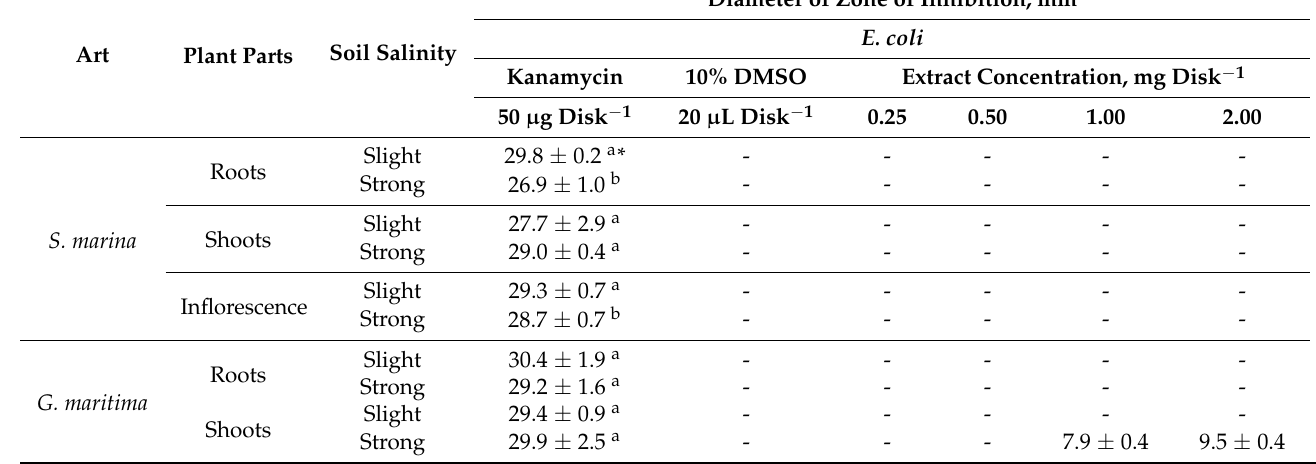
Table 5. Antibacterial and fungicidal activity of extracts from different parts of the studied plants S. marina and G. maritima at different levels of soil salinization (the inhibition zones include the diameter of the disk—6